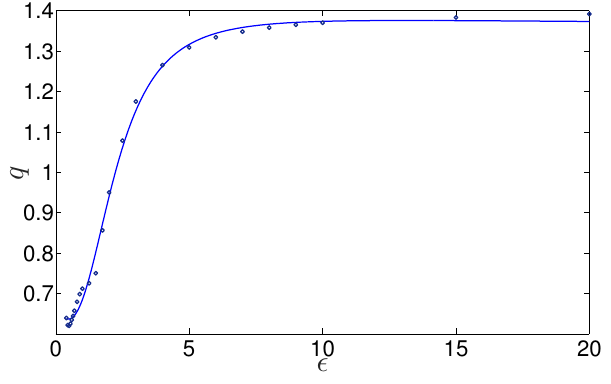
Figure 9 . Dependence of the CC ansatz tuning parameter q on the curvature-controlling model parameter ǫ . The data points and the corresponding fitting curve [given in eq. (4.13)] represent the relation between the “optimal” value of q (under the notion of optimality defined in the text) and our φ 6 model’s free parameter ǫ